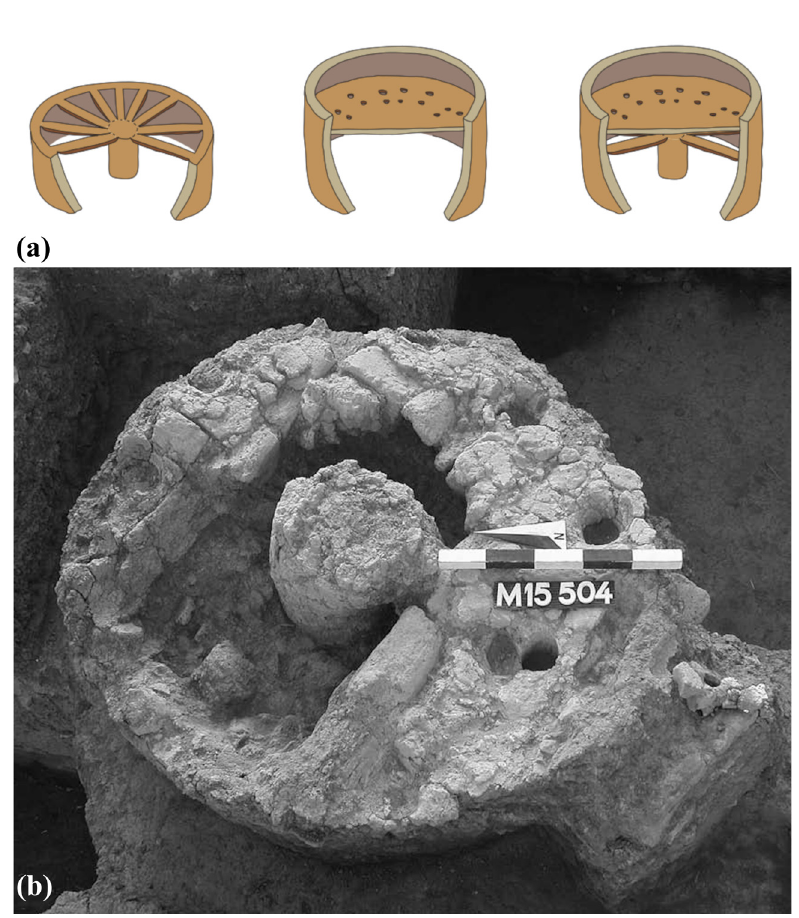
Figure 4: ( a ) Hypothetical reconstruction of the kiln presented in this article based on the excavation results. Drawings by Jens Rohde; ( b ) Darre ye - Bolaghi. Kiln 504 ( site 131 ) ( Helwing and Seyedin, 2016, Figure 17.8 ) . Image reproduced with permission of the Oriental Institute, University of